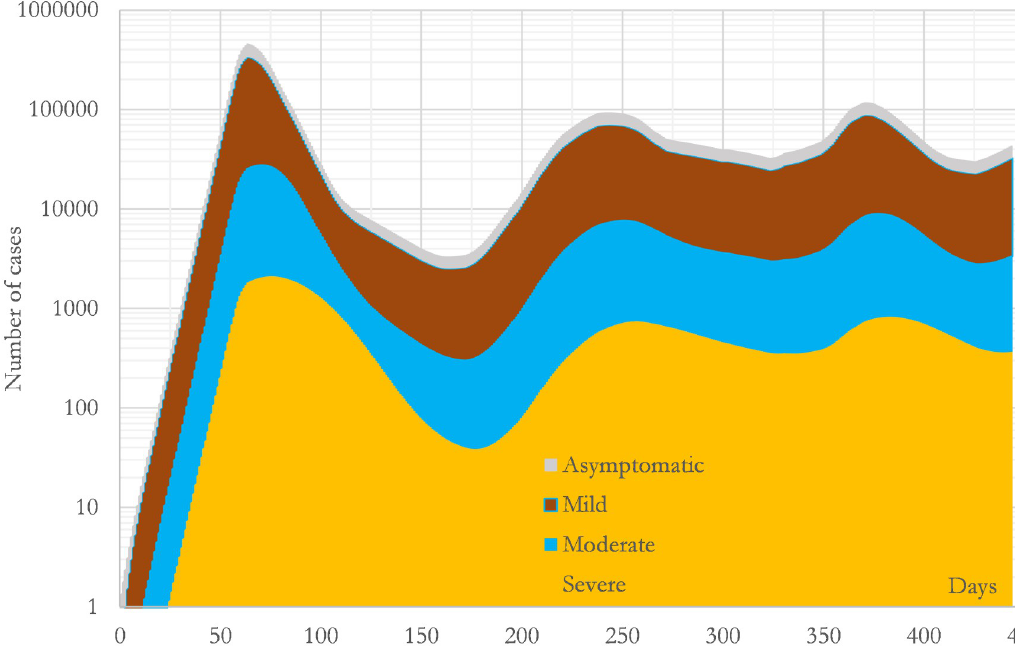
Fig 5. Calculated evolution of the daily prevalence during the studied period in the region of Madrid (CM). The curves present the number of infectious individuals who existed each day segregated by types. All the curves have been calculated with the convolution mathematical model presented in this study using the parameters collected in Table 3.